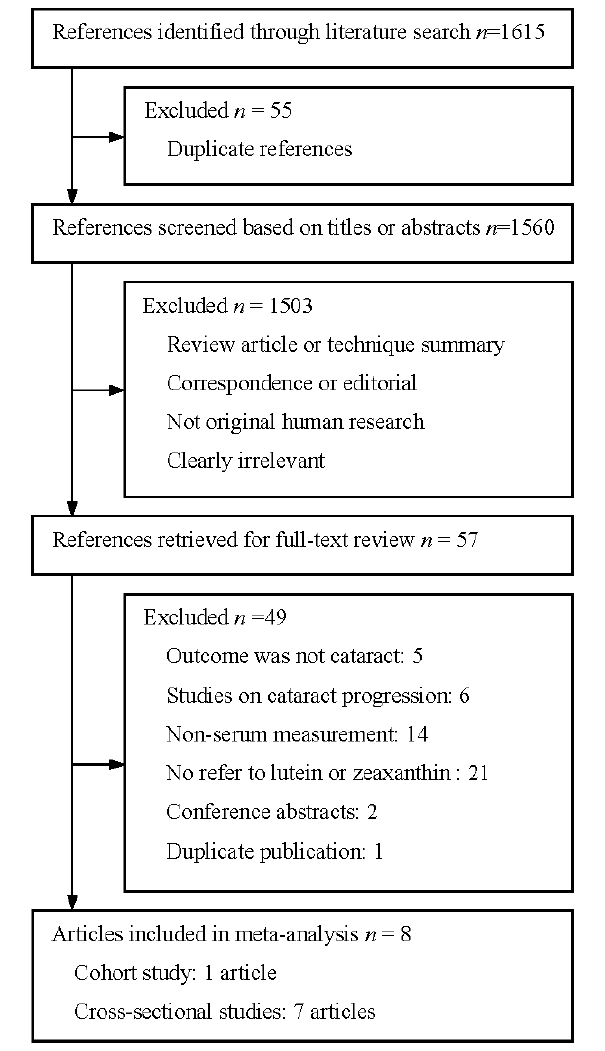
Figure 1. Flow diagram of study selection